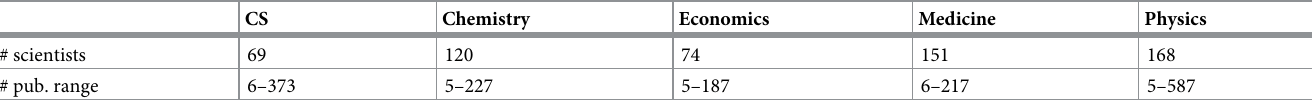
Table 2. Sample size of scientists per award category and range of number of